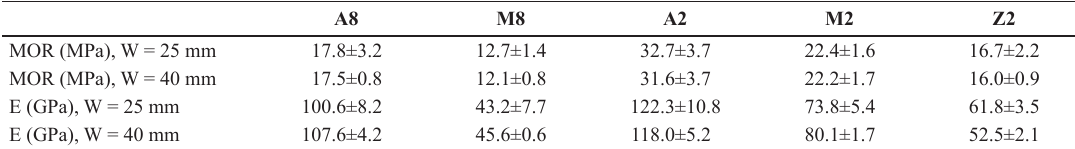
Figure 4. Generation of a data group of retained-MOR for the small bars by combining individual MOR-values results before and after thermal shock test. The term “TS” refers to the values of MOR after thermal shock. Table 3. Values of MOR and E of bar-like specimens of the castables for the two values of W.